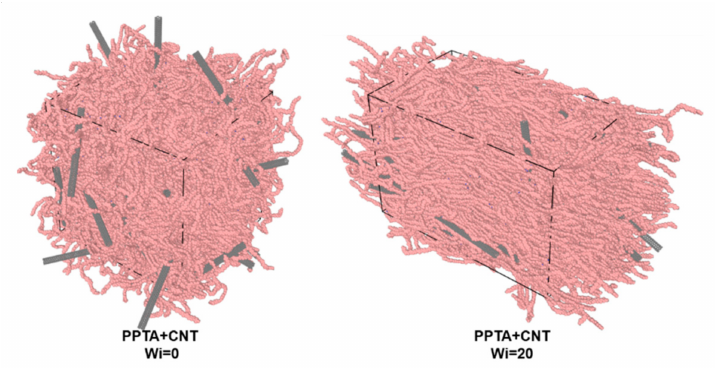
Figure 2. Molecular system for mechanical simulation of PPTA + CNT composite